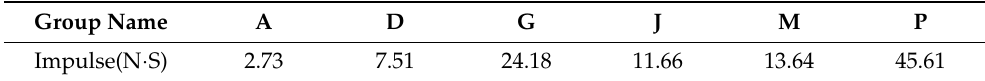
Table 10. Impulses under various working